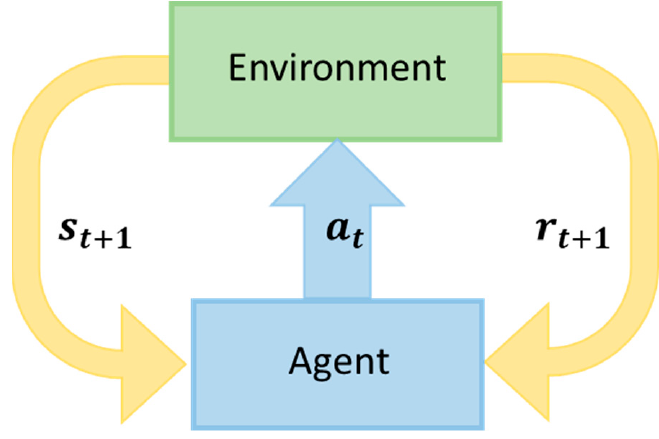
Figure 2. Agent and environment interaction in RL .